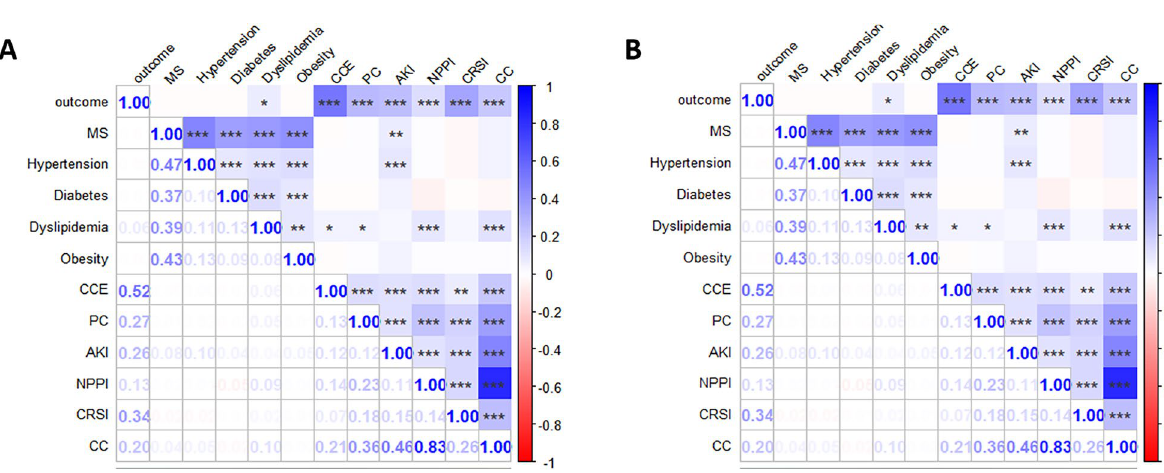
Figure 3. Overall correlations between outcomes and MS or CC and their components. *** P < 0.001, ** P < 0.01,* P < 0.05. ( A ) 30-day spearman results; ( B ) 90-day spearman results. MS: Metabolic